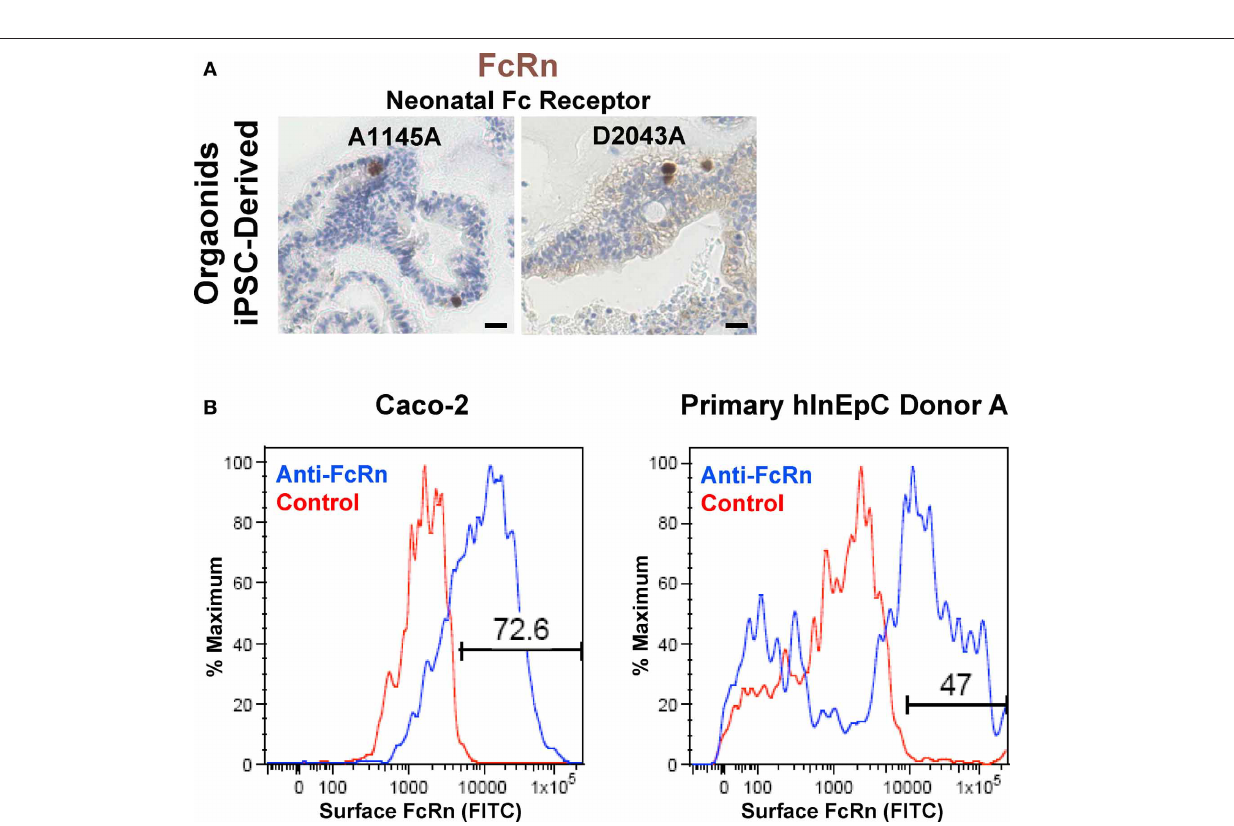
1 . 5 × 10 − 6 cm/s. Only transwells that met this cutoff were used to calculate Papp ratios for Digoxin and Atenolol ( Figure 6 ). N = 3; Error bars represent SEM.